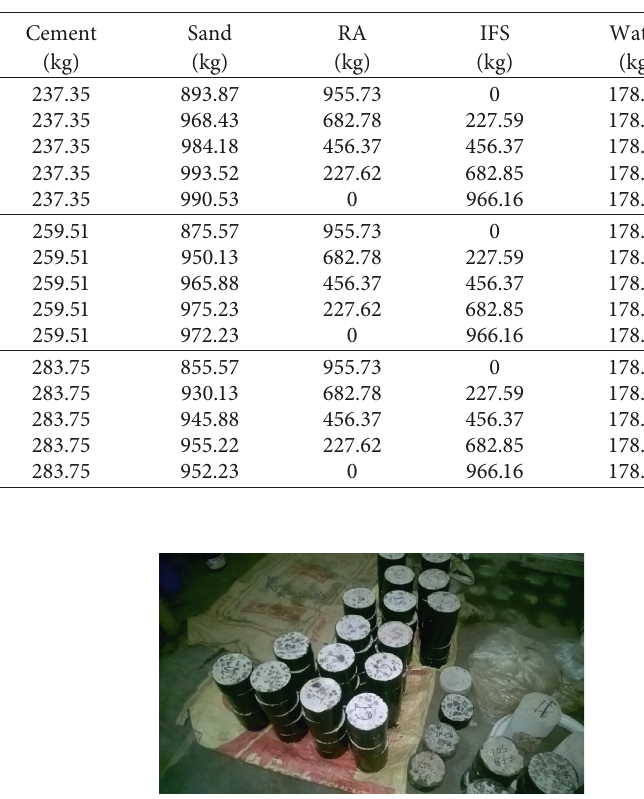
Table 3: Concrete mix design (quantity for 1m 3 of concrete).